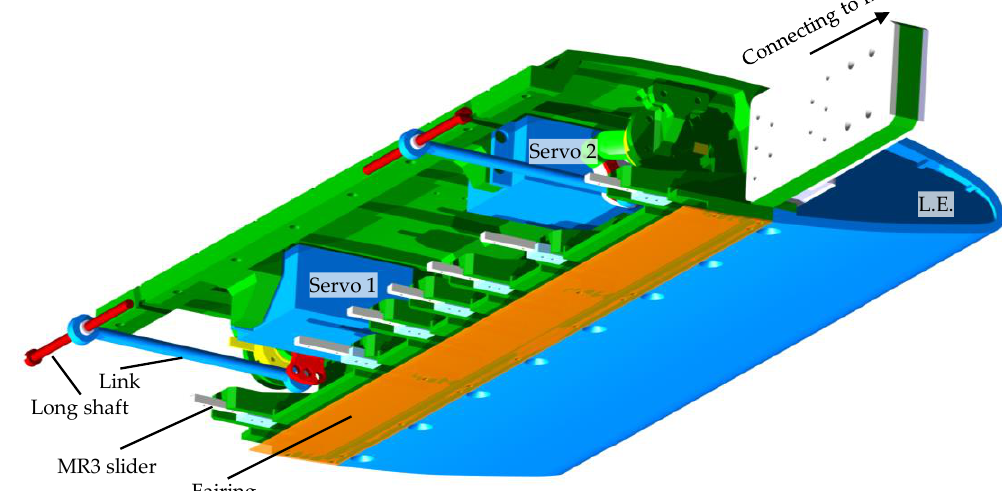
Figure 7. Wing box and leading edge of mTE4.